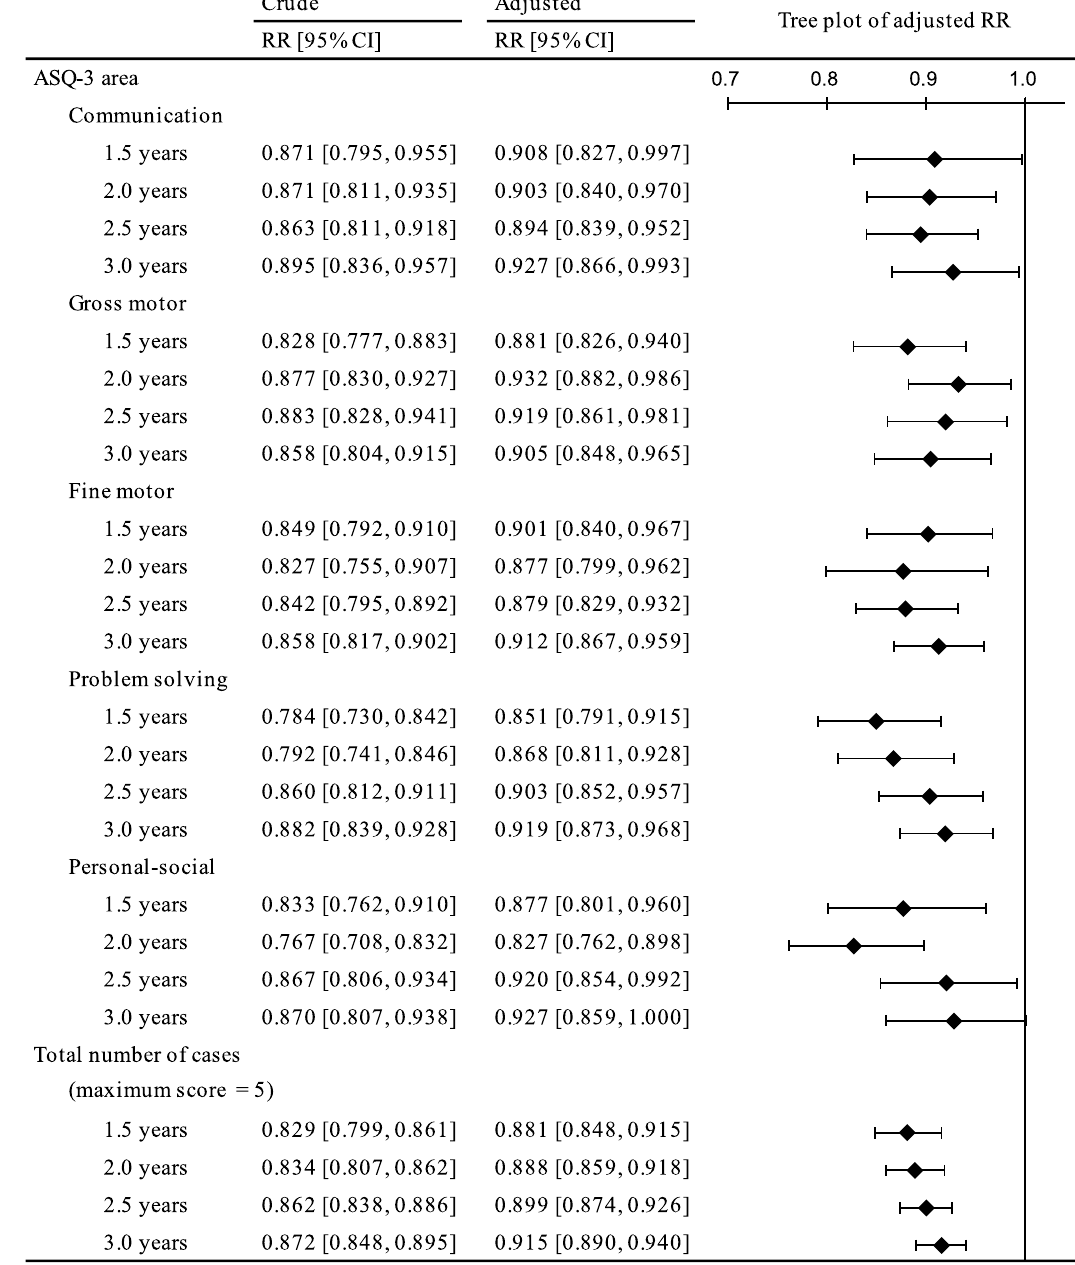
Figure 2. Tree plot of adjusted risk ratios (RRs) and 95% confidence intervals (CIs) for cases of developmental delay at four time points in various areas of the Ages and Stages Questionnaire, Third Edition, and the total number of cases with air purifier use (reference = nonuse of air purifiers). Based on imputed data for the 82,457 mother-toddler pairs in this study. Adjusted for maternal age, body mass index, parity, smoking status, passive smoking status, alcohol intake, number of hours spent outdoors, physical activity, folic acid intake, marital status, highest educational level, employment status, annual household income, type of residence, high-rise living, number of rooms in house/apartment, living room flooring material, age of house/apartment building, house renovation/interior completion after becoming pregnant, number of years living in current place of residence, and due date of delivery, with the 19 regional areas set as a random